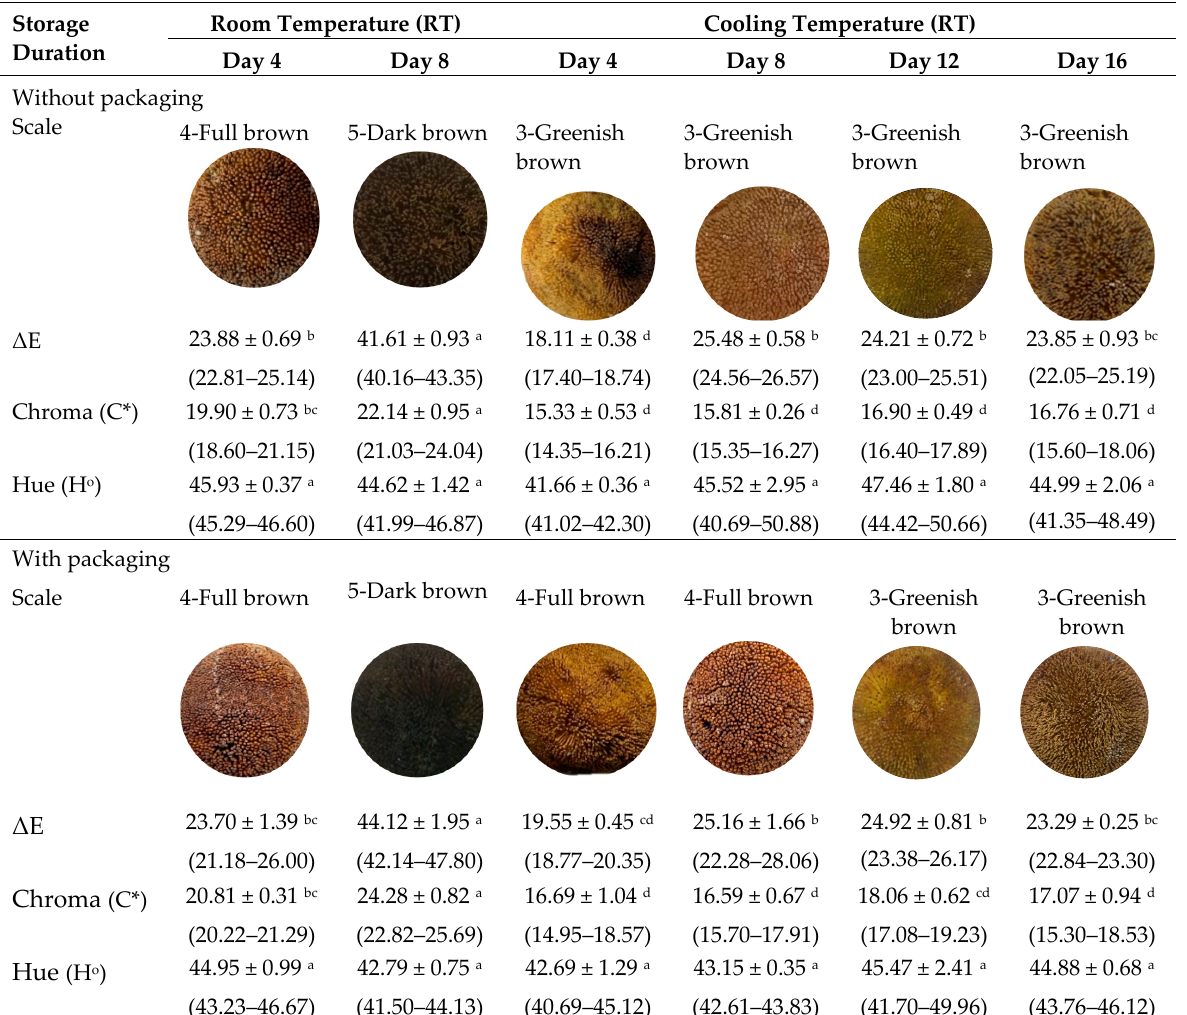
Figure 1. Peel total color changes ( Δ E), chroma (C*) and hue (H o ) values of Artocarpus odoratissimus at various postharvest treatments. Different superscript alphabets indicate differences in the same row (with and without packaging) at p < 0.05 (ANOVA, Tukey’s test). Values are given as means ± standard error, and values in parenthesis are the range.